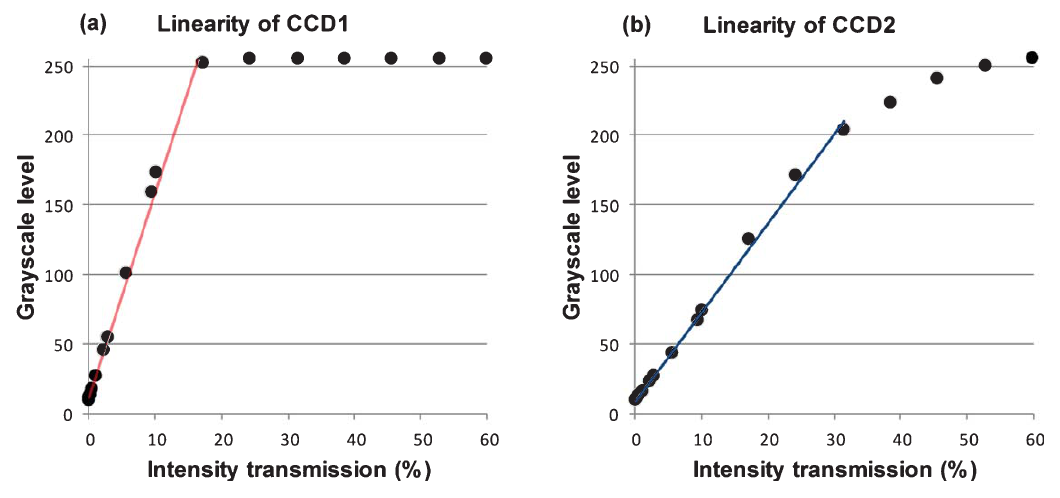
Fig. 5. The linearity profiles of the CCD detectors. The profiles are plotted as intensity transmission versus grayscale levels demonstrated linear but varied profiles before reaching the saturation